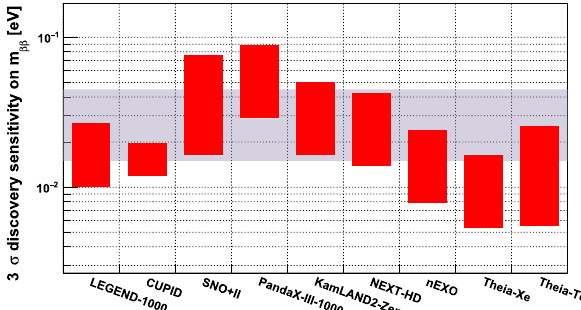
Fig. 19 Discovery sensitivity (3 σ ) for proposed future experiments. The grey shaded region corresponds to the parameter region allowed in the Inverted Hierarchy of the neutrino mass. The red error bars show the m ββ values such that an experiment can make at least a 3 σ discovery, within the range of the nuclear matrix elements for a given isotope. The parameters of the other experiments are taken from Refs.